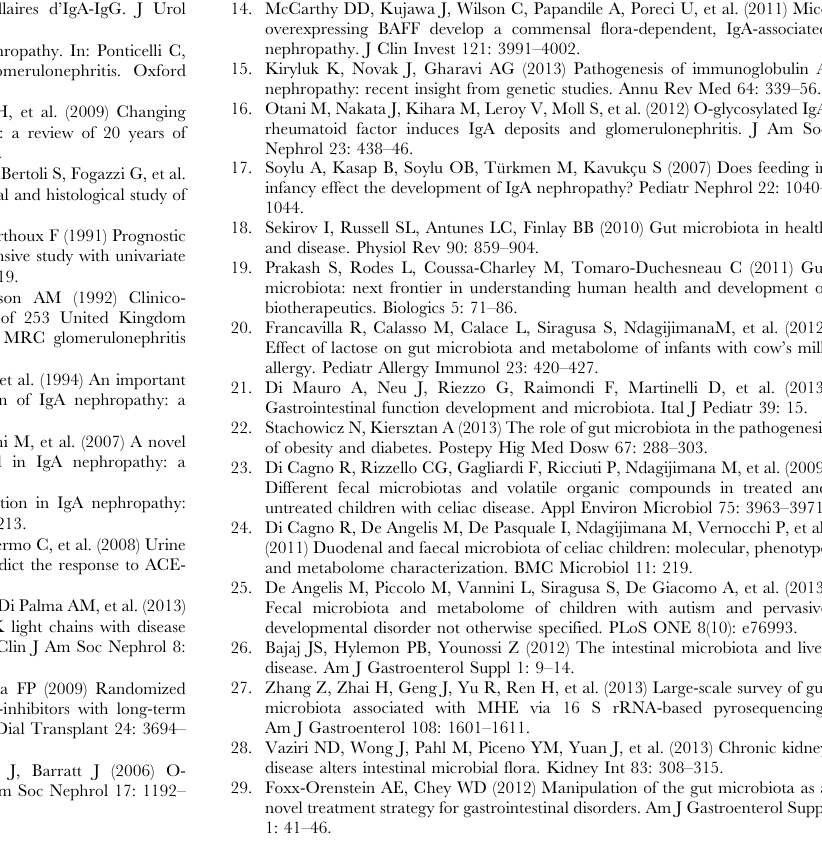
Figure S2 Permutation analysis. Permutation analysis of the total (16S rDNA) and metabolically active (16S rRNA) bacterial families composition found in fecal samples of immunoglobulin A nephropathy (IgAN) non progressor (NP) and progressor (P) patients, and healthy controls (HC). (TIF) Table S1 Concentration (ppm) of volatile organic compounds (VOC).